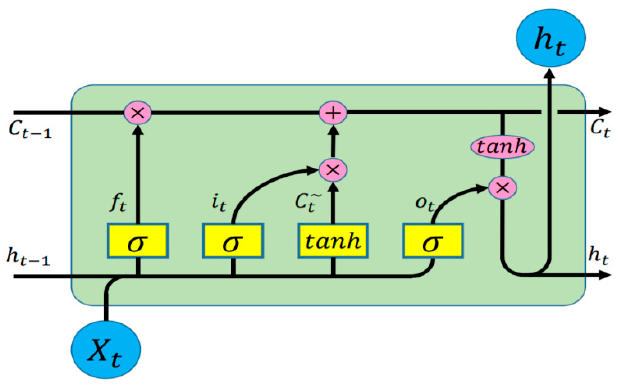
Figure 2. Long short-term memory (LSTM) cell.